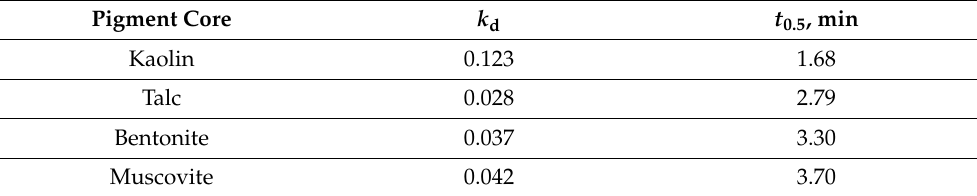
Table 4. Dispersibility of core/shell pigment with PANi shell doped with sulfuric acid. Pigment Core k d t 0.5 , min Kaolin